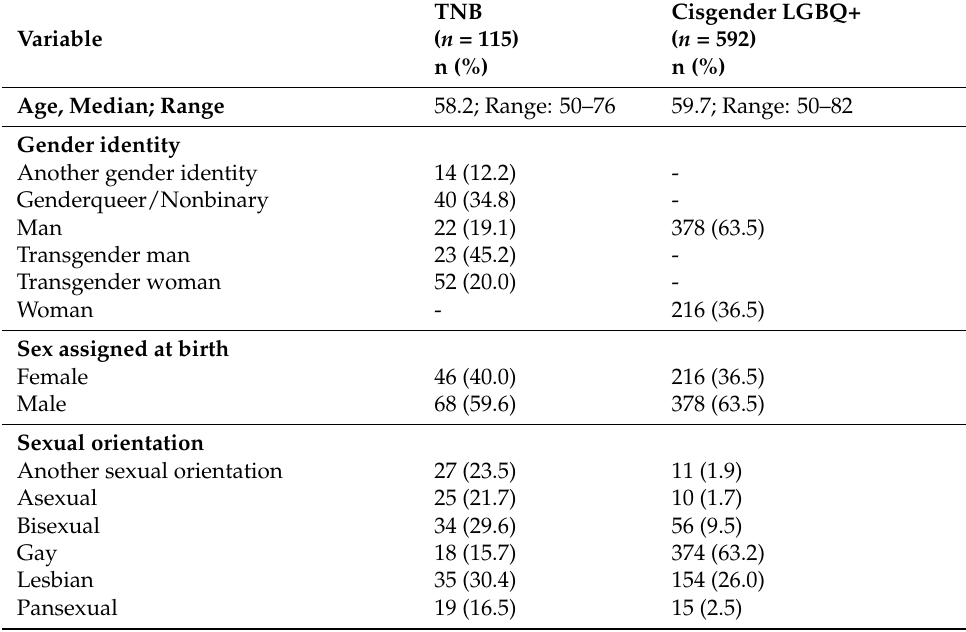
Table 1. Demographic Characteristics for Transgender and Nonbinary and Cisgender Lesbian, Gay, Bisexual, Queer, and Another Identity Older Adults ( n =